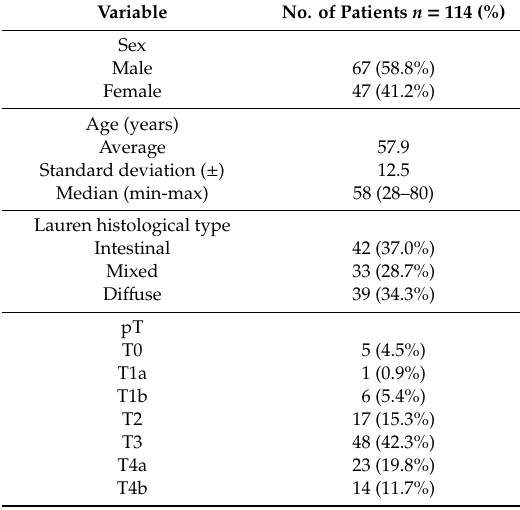
Table 1. Clinicopathological variables of all patients included in the